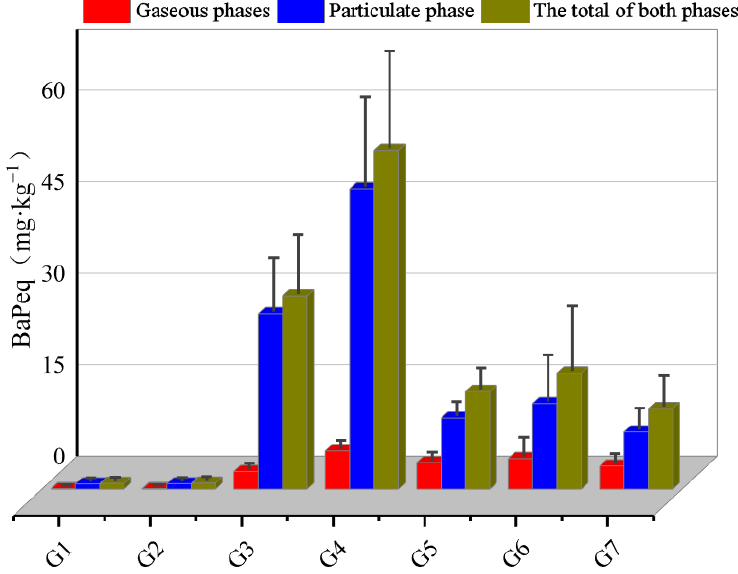
Figure 1. The gas and particulate phases BaPeq of seven fuel – stove combinations.